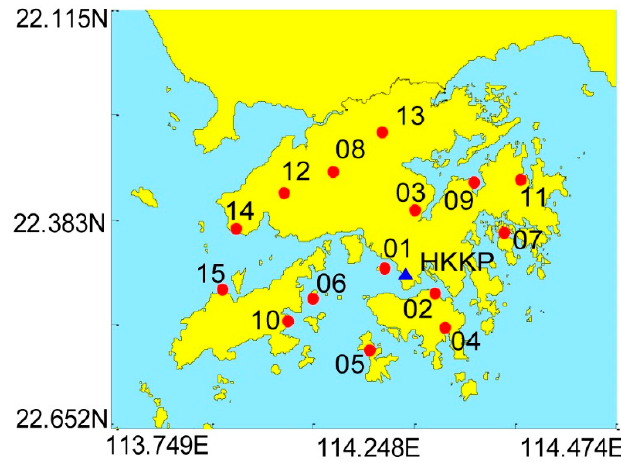
Figure 7. The horizontal distribution of the GNSS stations (red dots), King’s Park Meteorological Station (HKKP) (blue triangle)—the ground observation station and the tomographic area for GNSS tomography.